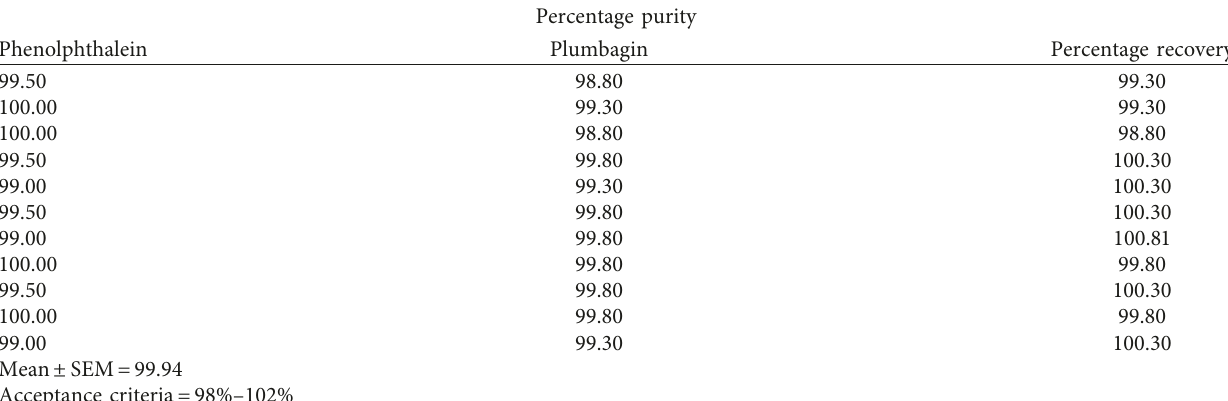
Table 2: Percentage recovery of ibuprofen BP using plumbagin as an indicator.